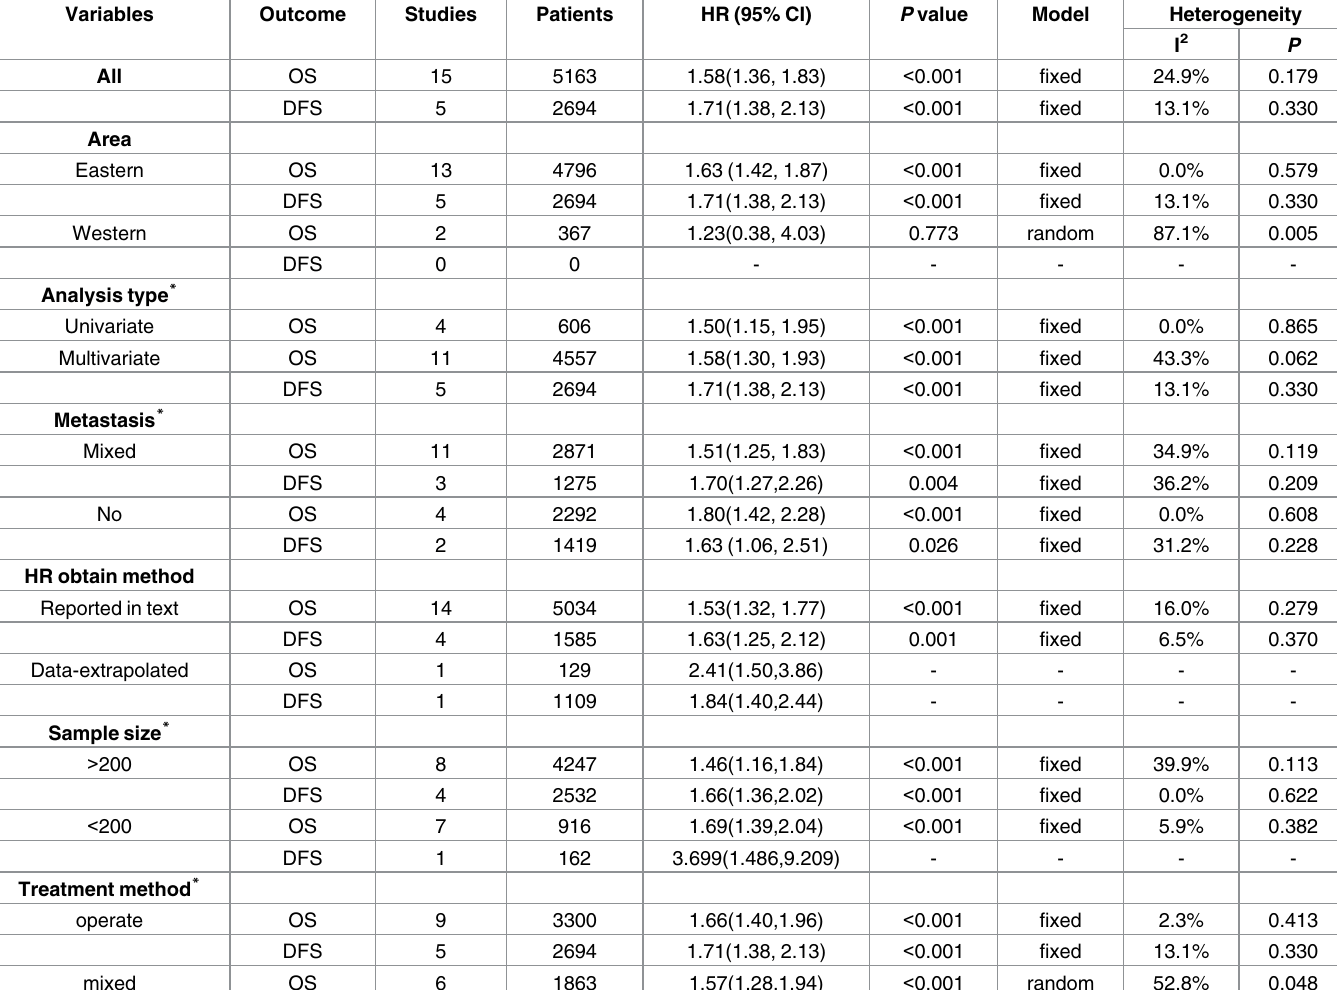
Table 2. Pooled hazard ratios (HRs) for OS according to subgroup